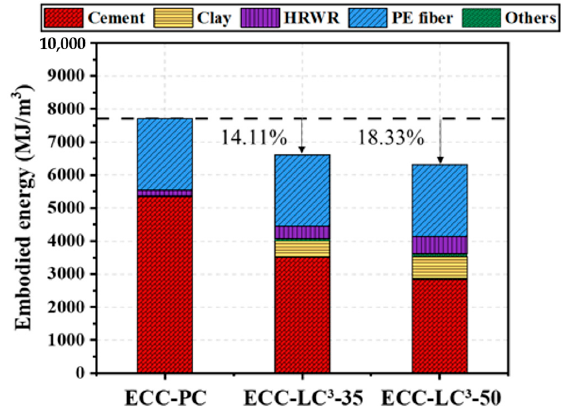
Figure 15. Summarization of the consumed energy by each component of ECC.